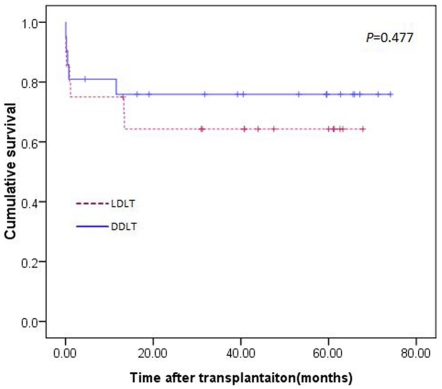
Survival curve of patients undergoing emergency liver transplantation (P = 0.477).